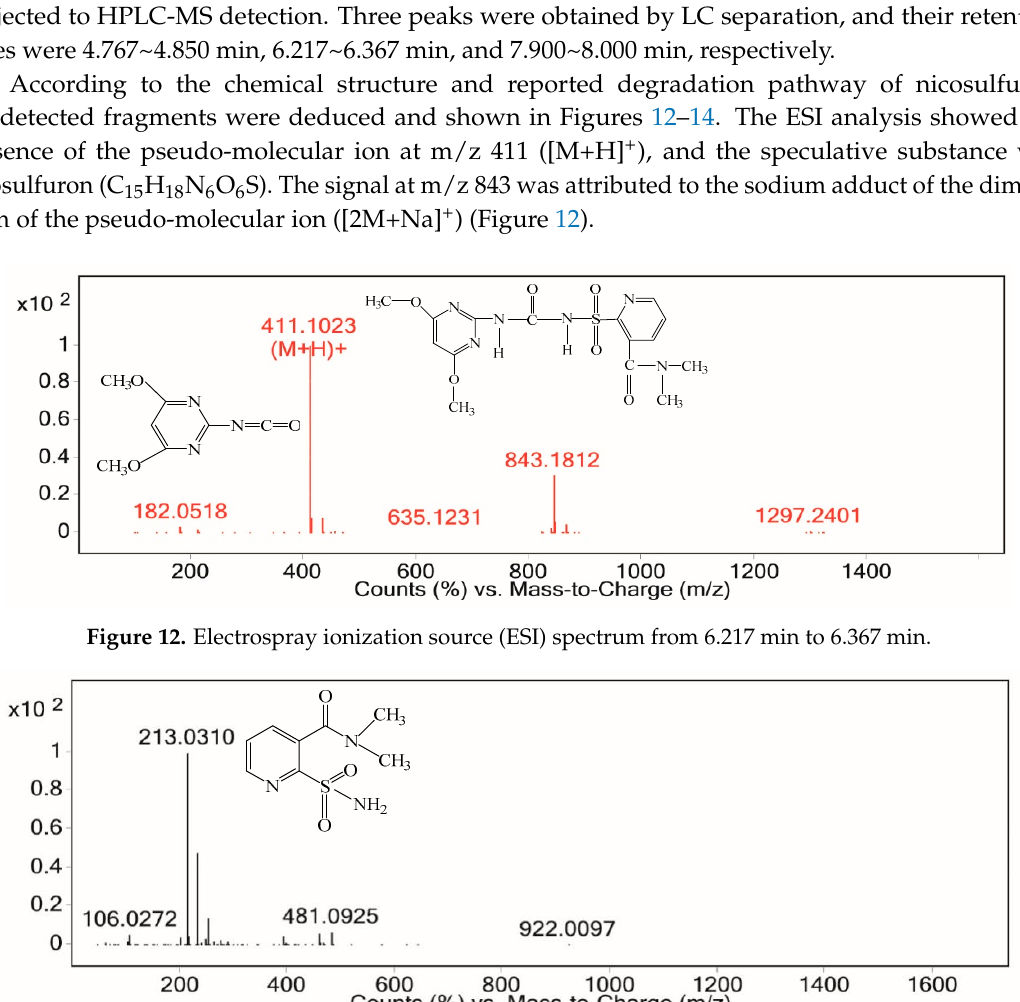
Figure 11. CV curves of the Ti/Ta 2 O 5 -IrO 2 electrode at different scan rates. ( A ) CV curves at different scan rates; ( B ) The plots of peak current vs. the square root of scan rate.